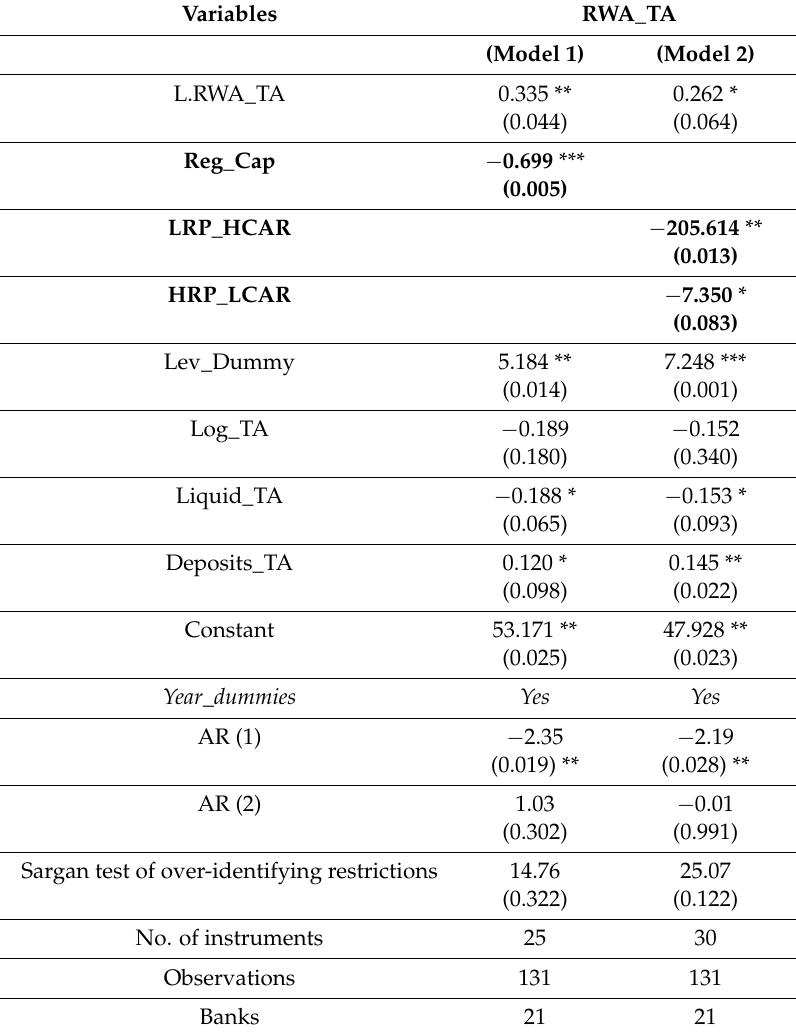
Table 4. Effects of regulatory capital requirements on bank